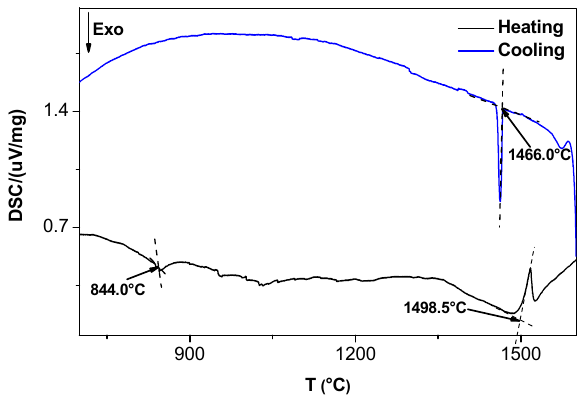
Figure 3. DSC (Differential Scanning Calorimetry) traces showing thermal events on heating and cooling of the alloy OHC3-AC.